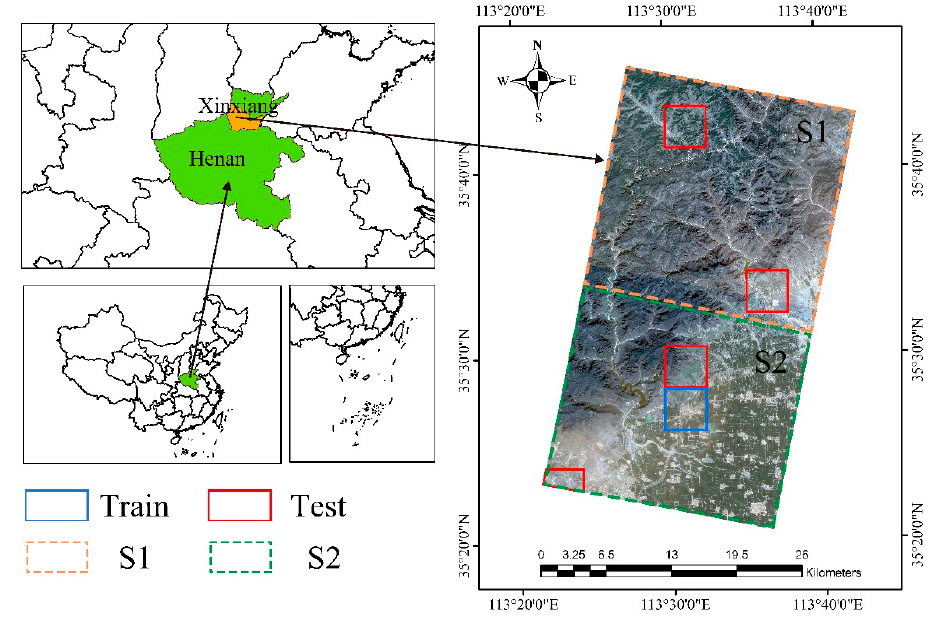
Figure 1. Location of the study area (leaf) and two scenes (S1 and S2) of Gaofen-2 (GF2). Train and test sample areas are labeled with a different color (blue for training and red for testing). Table 1. Land cover description and the number of available polygons and pixels for training and testing for each class.